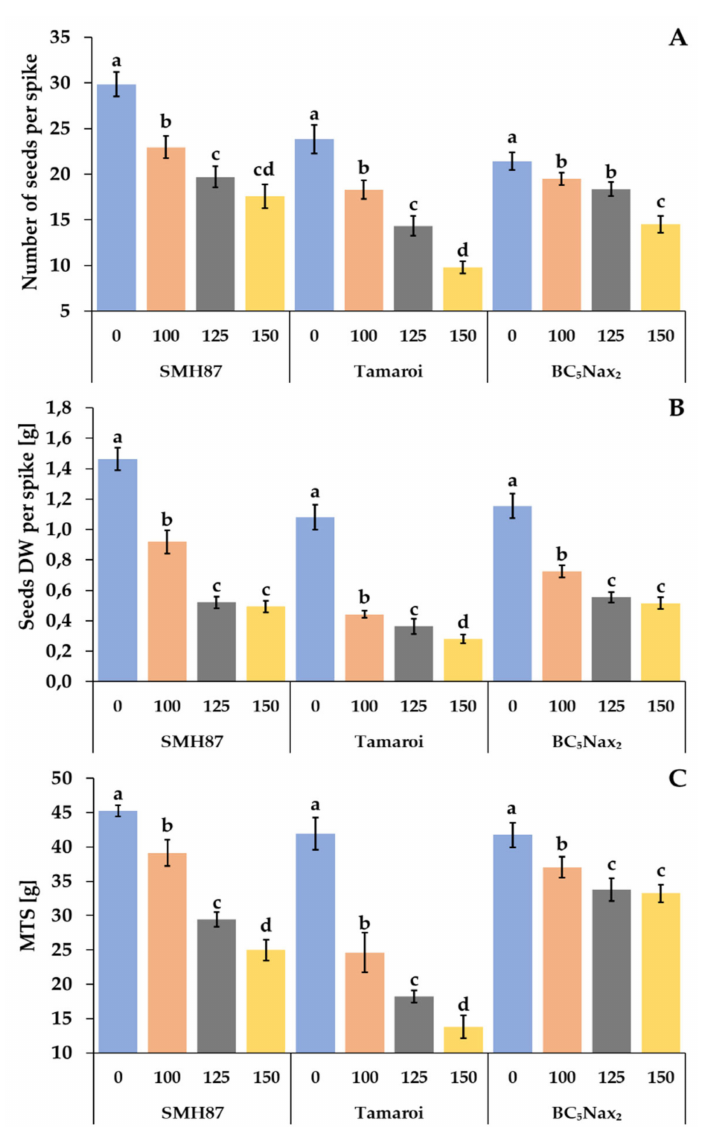
Figure 7. Effects of NaCl treatments (0, 100, 125, 150 mM) on yield components: number of seeds per spike ( A ), seed DW per spike ( B ), and MTS—mass of one thousand seeds ( C ). The values represent means (n = 3) ± SE within each accession, and those marked with the same letters do not differ statistically according to multiple range Duncan’s test ( p <